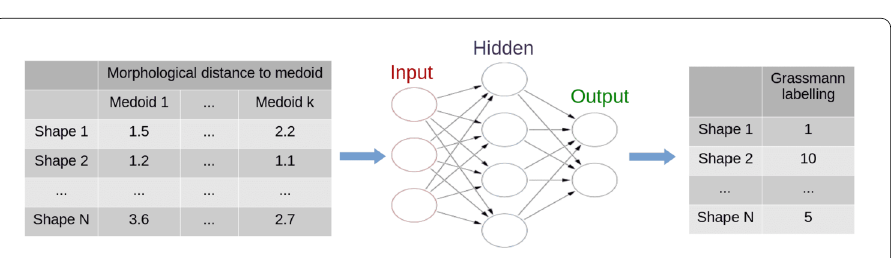
Figure 10 Classifier methodology